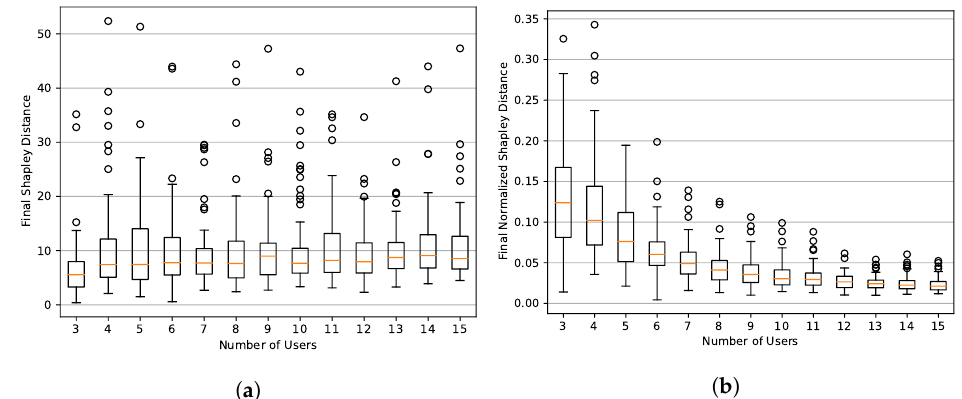
Figure 6. Boxplot of final Shapley distance ( a ) and normalized Shapley distance ( b ) with nucleolus in 1000 trials broken down by the number of users in the